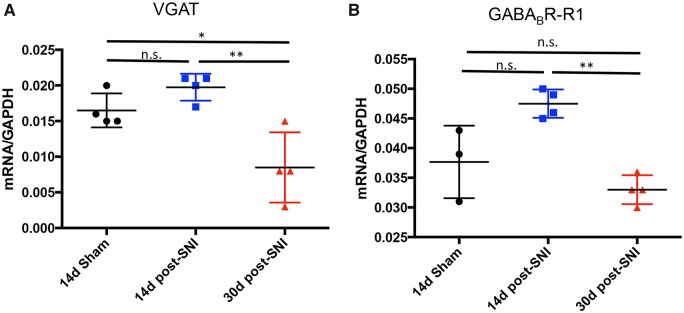

Gene expression (qPCR) in the rACC after peripheral nerve injury. (A) Slc32a1/VGAT mRNA decreases in nerve-injured mice (n = 4), compared to sham (n = 4), 30 days after SNI. All values were normalized to Gapdh (one-way ANOVA, Tukey’s multiple comparisons test; *P < 0.05; **P < 0.01). (B) Gabbr1/GABA-B-R1 mRNA is transiently upregulated in the rACC 14 days after SNI (**P < 0.01), but returns to baseline by 30 days post-injury (one-way ANOVA, Tukey’s multiple comparisons test; not significant).